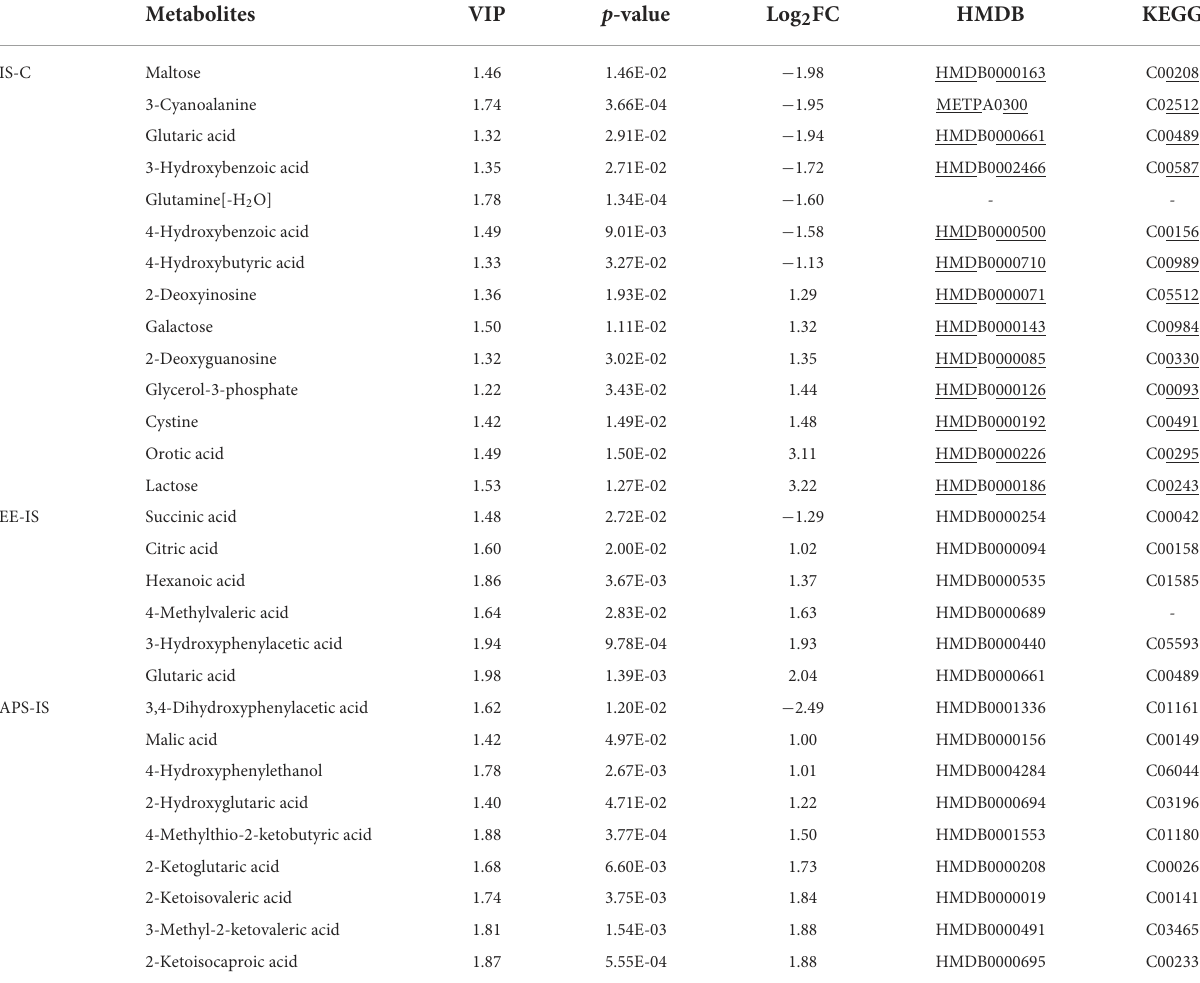
TABLE 2 Differential metabolites of intestinal contents in each group at 7 days (|Log[2]FC| ≥ 1). Metabolites VIP p -value Log 2